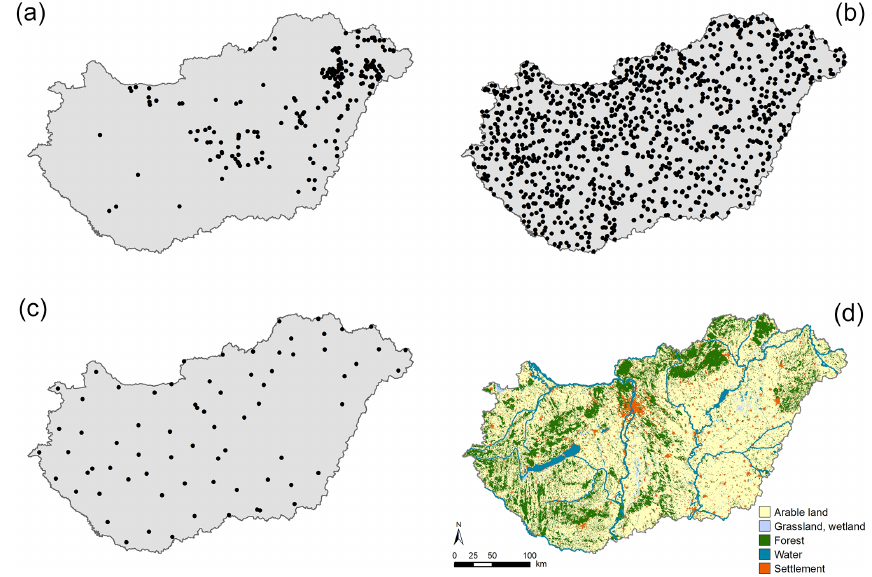
Figure 3. The spatial distribution of sampling points used in the present study: soil sample locations used in wind tunnel measurements (a) , SIMS location used in the compilation of soil fractions and texture maps (b) , meteorological stations used in long-term wind speed calcula- tions (c) , and Hungary’s general land cover conditions (d) .